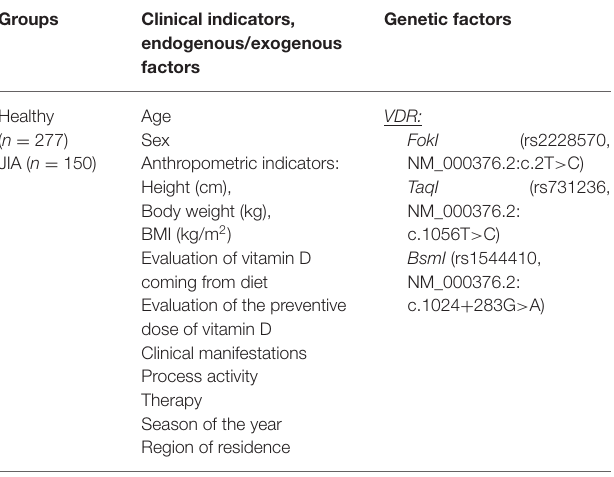
TABLE 1 | Design of our multicenter study evaluating the association between endogenous, exogenous, and genetic factors and vitamin D deficiency among children and adolescents with